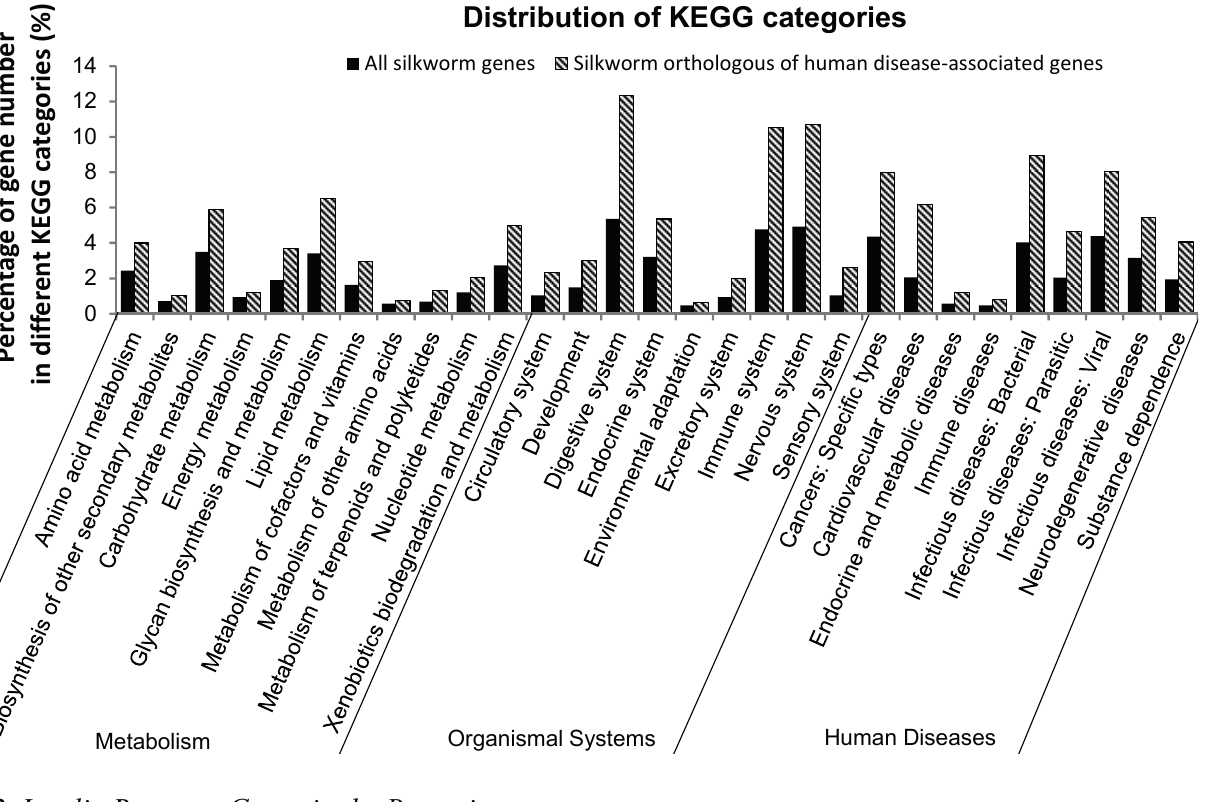
Figure 3. Pathway analysis of silkworm genes associated with human disease. The analysis was performed using BLASTP against KEGG database. The pathways were clustered with three different systems, metabolism system, organismal system and human